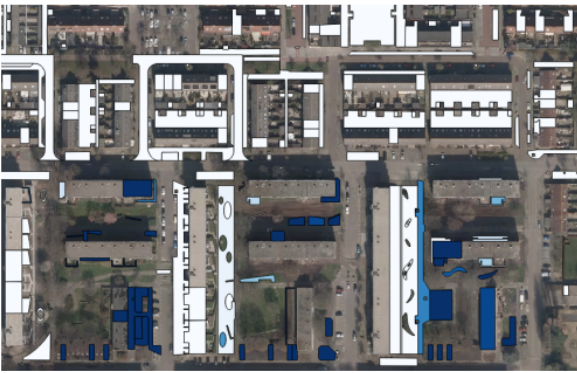
Figure 4. Example view for the operator